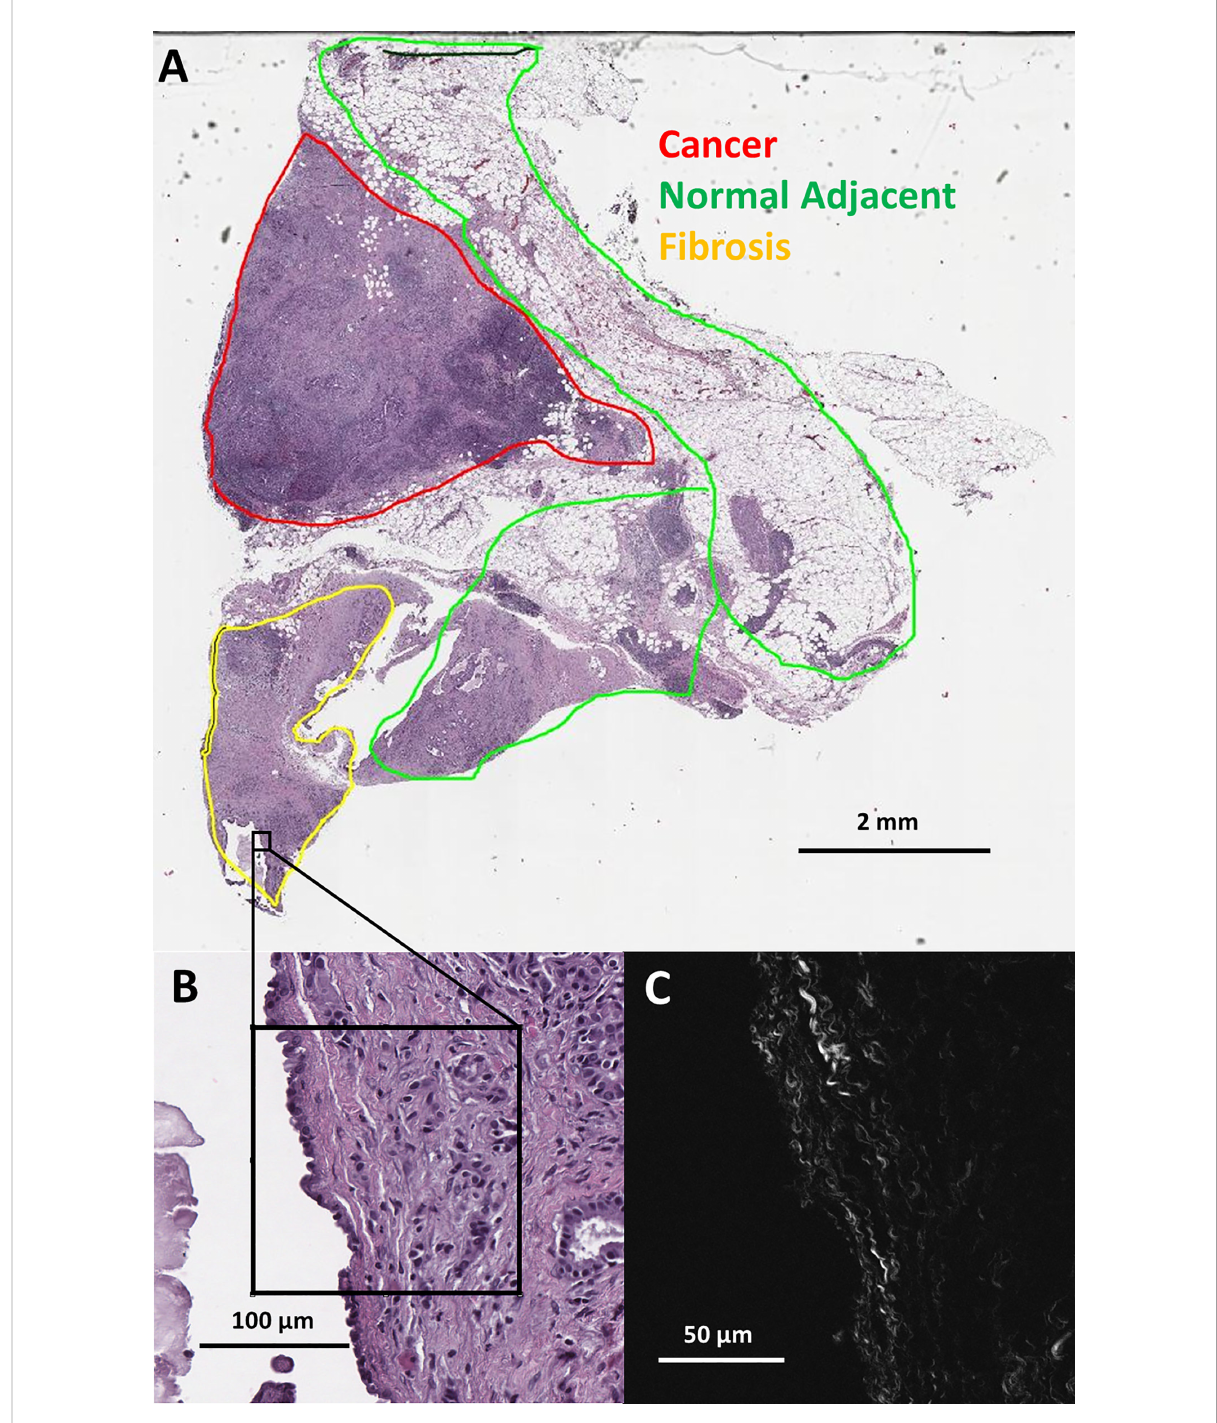
FIGURE 1 (A) Pathologist labeled H&E slide scan from a pancreatic tumor biopsy with an example of one SHG microscopy imaged area outlined in black. (B) Zoomed view of outlined area from H&E scan. (C) SHG microscopy image of outlined